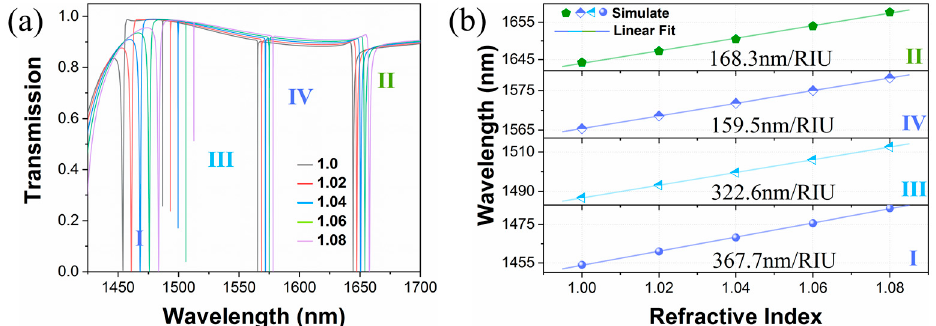
Figure 9. ( a ) The transmission curves with respect to the increasing refractive indices of the surrounding environment from 1.0 to 1.08. ( b ) The calculated resonant wavelengths as a function of medium refractive indices and the linear fit results for four modes. Table 2. Comparison of performance.